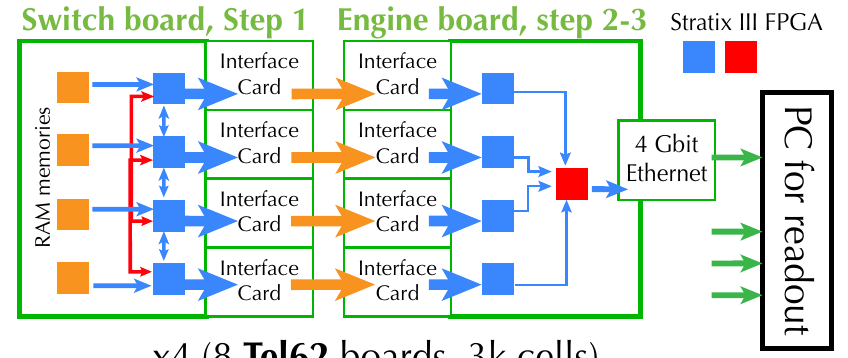
Figure 5: Architecture of the first prototype using Tel62